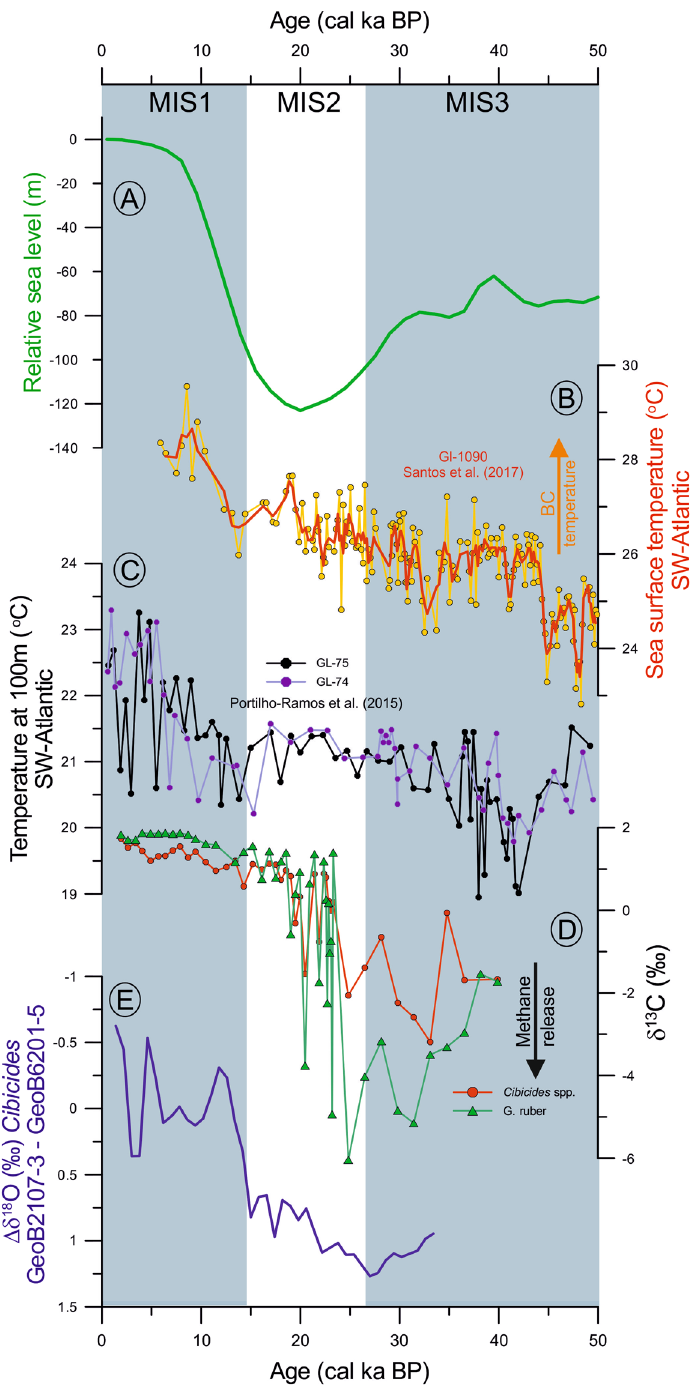
Figure 3. Response of methane release from the southern Brazilian margin to paleoceanographic changes over the last 50 cal ka BP. ( A ) Relative sea level changes over the last 50 cal ka BP 55 . ( B ) Sea Surface temperatures derived from Globigerinoides ruber Mg/Ca from core GL-1090 57 . ( C ) Temperature at 100m-water depth estimated using the modern analogue technic based on planktonic foraminifera from cores GL-75 and GL- 74 58 . ( D ) Stable carbon isotope ( δ 13 C) records of Cibicides spp. and Globigerinoides ruber showing the strong depletion that indicate methane release from the SBM between 40 and 20 cal ka BP (this study). ( E ) Vertical thermal gradient in the southern Brazilian margin derived from the stable oxygen isotopic differences ( δ 18 O) of Cibicides spp. between core GeoB6201-5 (at 475 m water depth) and GeoB2107-3 (1048 m water